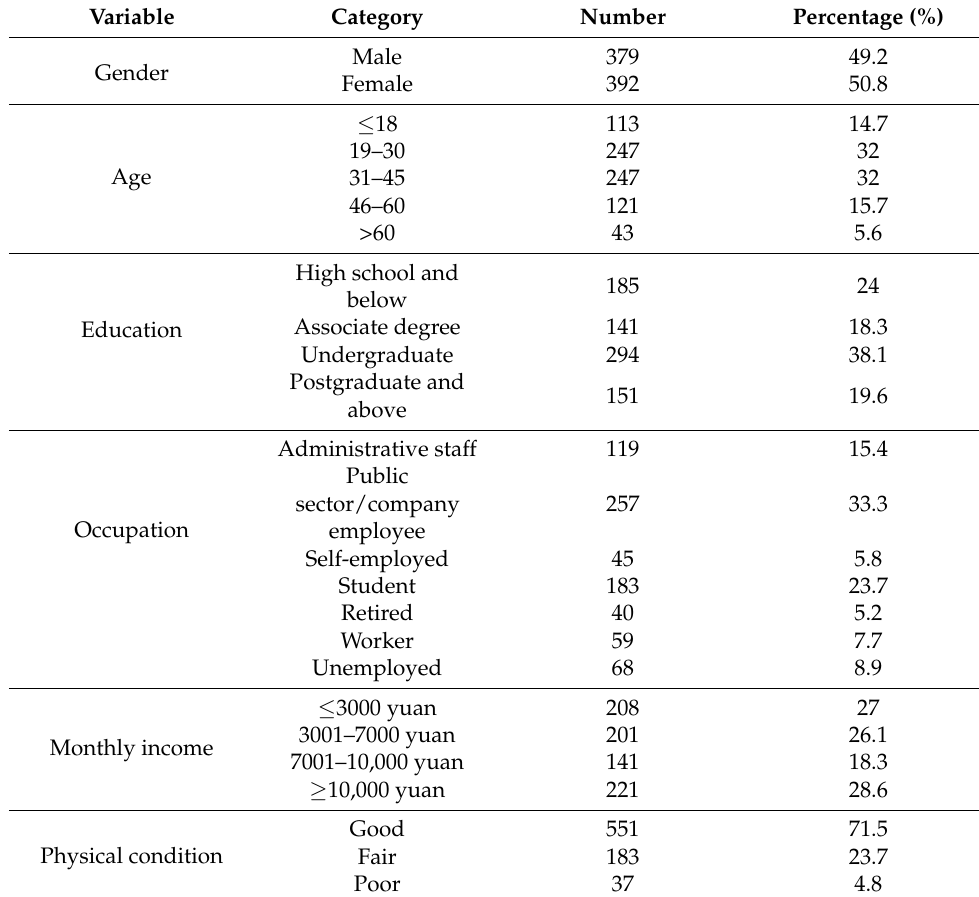
Table 1. Descriptive statistics of the demographic